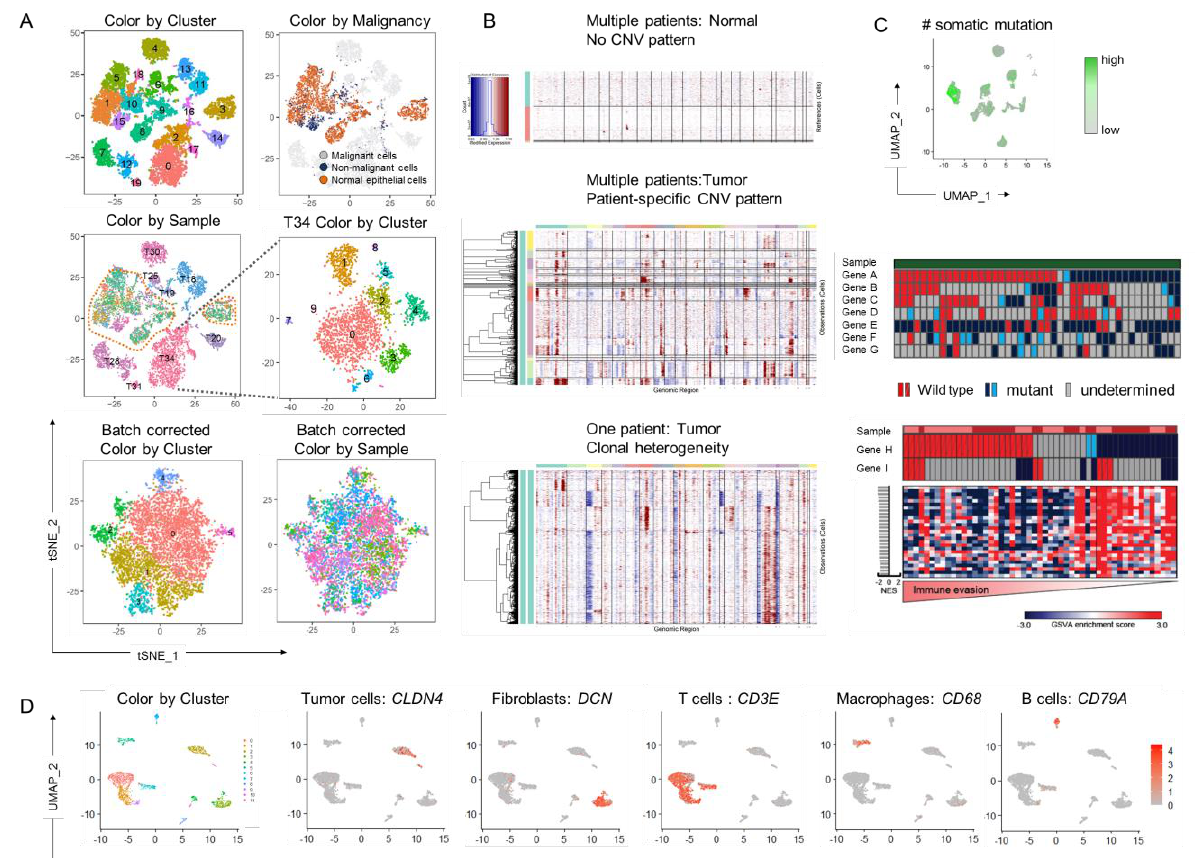
Figure 1. Cellular heterogeneity in cancer depicted by single cell transcriptome analysis. ( A ) Clustering analysis shows patient-specific tumor groups in multiple samples (Color by Sample) compared to the multi-patient clustering of normal and non-malignant cells (orange dotted outline). Intratumoral heterogeneity in a selected patient sample is depicted in T34 Color by Cluster. Batch correction by multi-set canonical correlation analysis (CCA) [6] clears the inter-patient cluster variation originating from both technical and biological sources (batch corrected tumor cell clusters: Color by Cluster and Color by Sample). ( B ) Copy number inference from gene expression data shows patient-specific patterns for tumor cells and intratumoral heterogeneity within a selected patient sample. ( C ) Somatic mutation calls separate a tumor cell cluster (upper UMAP) and demonstrate intratumoral heterogeneity in individual cells (lower heatmaps). ( D ) Diverse stromal and immune cell types in the tumor microenvironment. Plots are arbitrarily generated to demonstrate the depicted features.